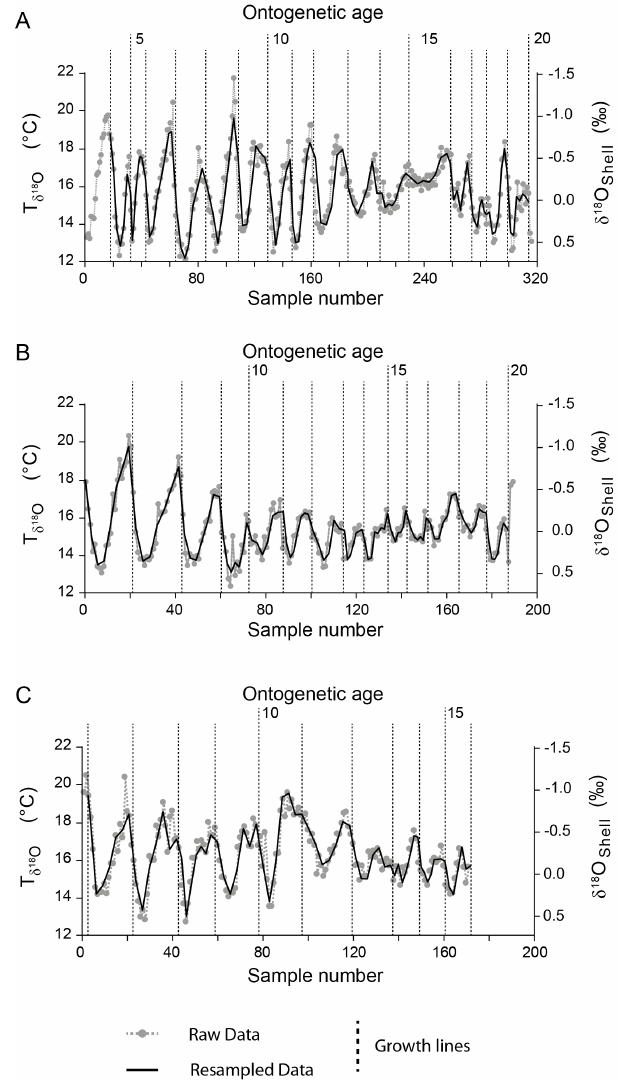
Figure 4. Raw (grey) and re-sampled (black) δ 18 O shell values for each of the three Glycymeris planicostalis shells analyzed in this study ( (a) = MB-Wht-2; (b) = MB-Wht-4; (c) = MB-Wht-7). Ver- tical dotted bars represent annual growth lines. Temperatures were calculated using Eq. (2) with a δ 18 O water value reconstructed from δ 18 O PO values of sea cow tooth enamel (see text for description). 4